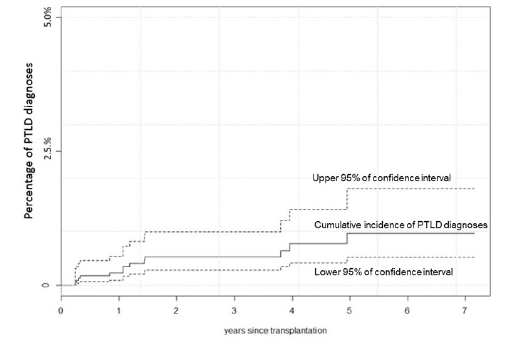
Figure 1: Post-transplant lymphoproliferative disorder cumulative incidence rate according to time after transplantation for solid or- gan transplant patients in the Swiss Transplant Cohort Study.